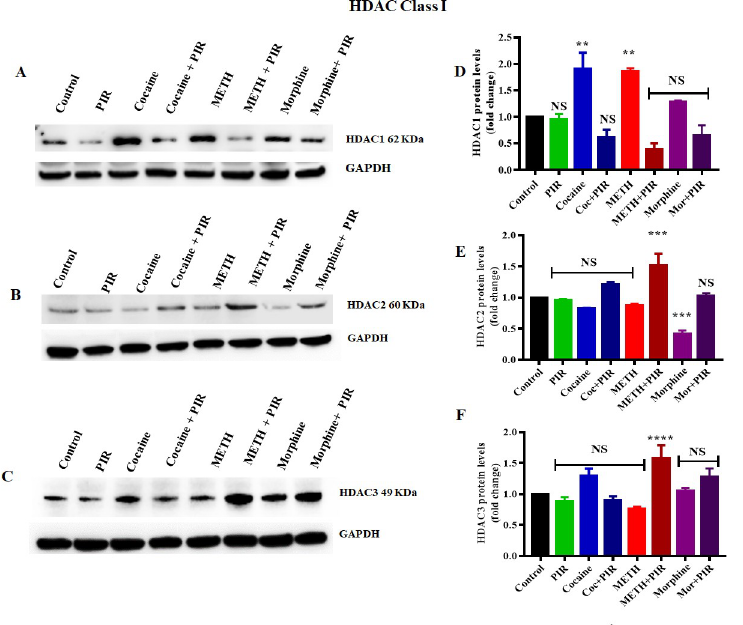
Fig 1. Effects of the psychostimulants cocaine, METH and morphine on HDAC class I proteins in human primary astrocytes. Cells were exposed to cocaine (1 μ M), METH (10 μ M), and morphine (5 μ M) either alone or in combination with piracetam (10 μ M) for 24 h. The protein expression levels of different classes of HDACs (1–3) in astrocytes were determined by western blotting analysis using GAPDH as a loading control. Western blot showing (A) HDAC1, (B) HDAC2 and (C) HDAC3. The densitometric analysis results in D, E and F represent the protein levels (fold-change control) of HDAC1, HDAC2 and HDAC3, respectively. Two-way ANOVA analysis performed to compare the groups between cocaine Vs cocaine + piracetam, METH Vs METH + piracetam and morphine Vs morphine + piracetam. The data are expressed as the mean ± standard error mean of three independent experiments. N = 3. ���� P < 0.0001, ��� P < 0.001, �� P < 0.01, NS—nonsignificant.